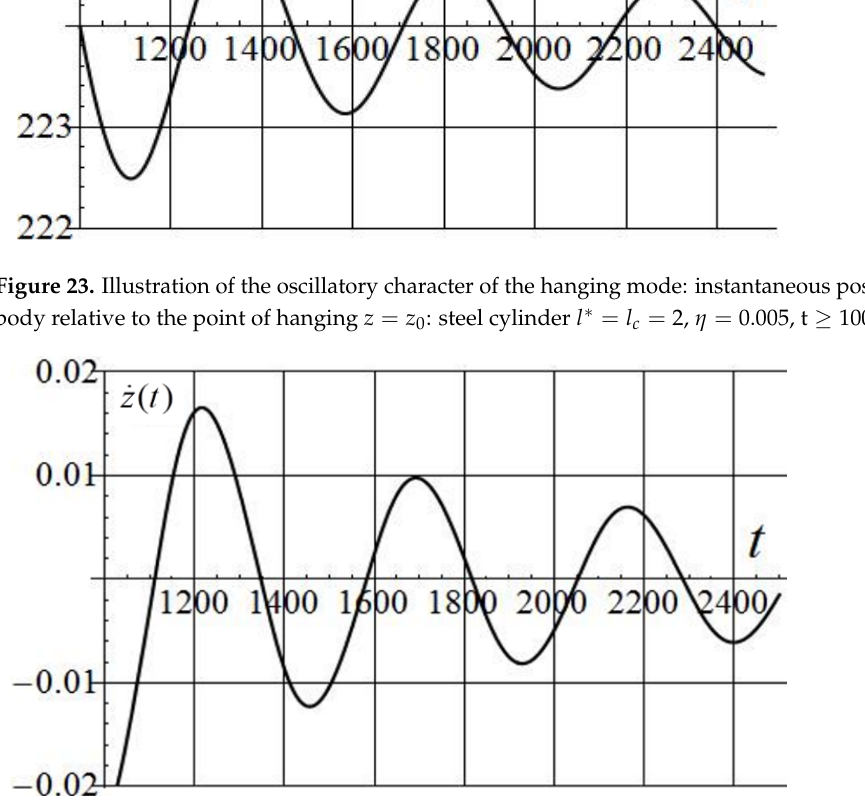
Figure 24. Illustration of oscillatory character of the hanging mode: speed of the body relative to . z ( z 0 ) = 0: steel cylinder, l ∗ = l c = 2, η = 0.005, t ≥ 1000